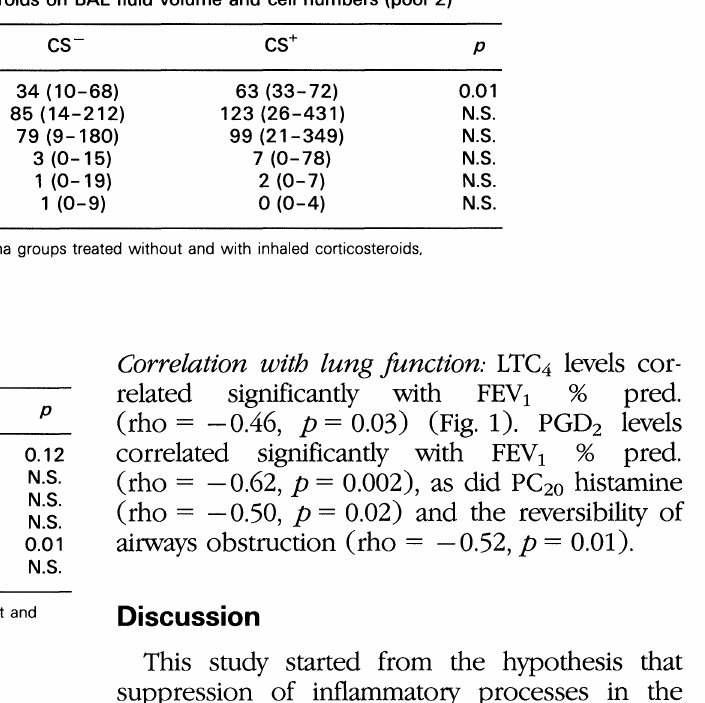
Table 4. BAL AA metabolite levels (pg/ml)